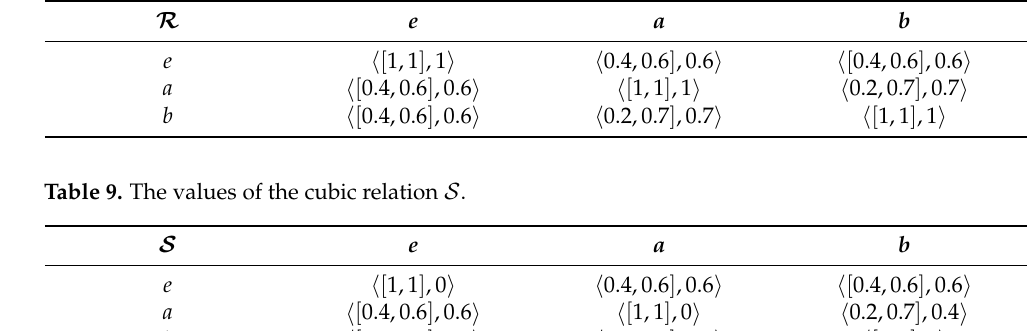
Table 8. The values of the cubic relation R .